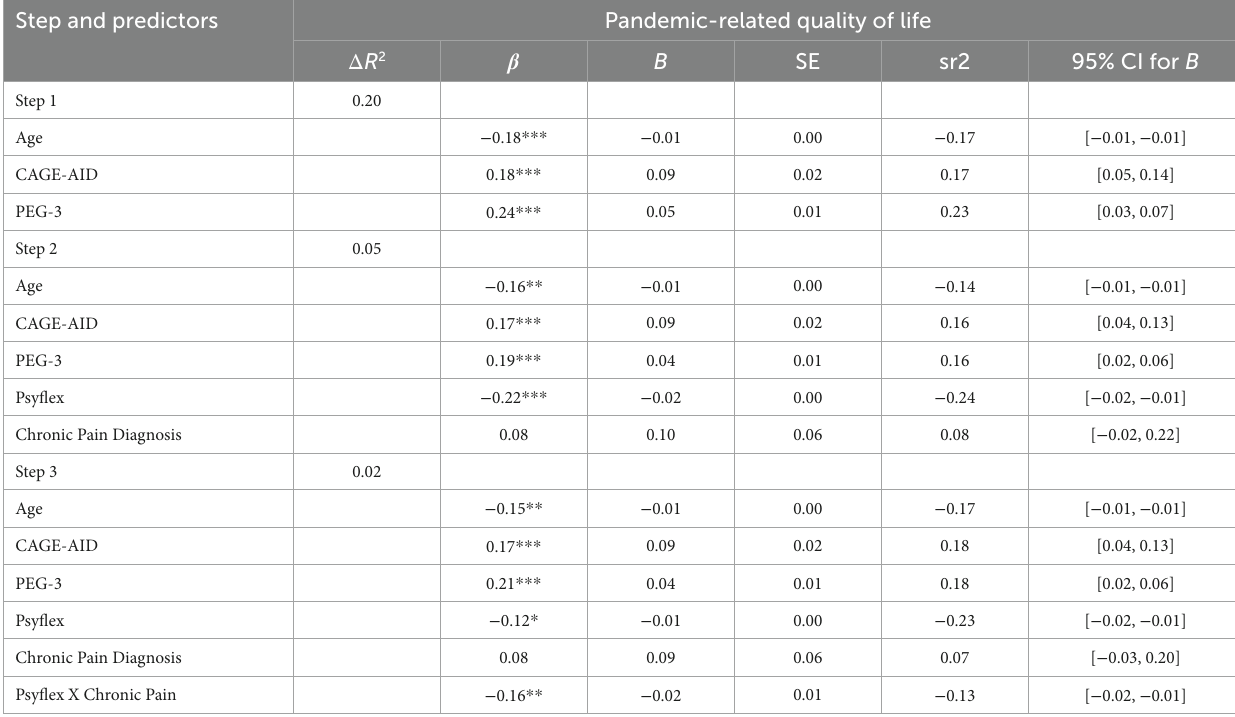
TABLE 4 Hierarchical multiple regression testing interaction model on pandemic-related quality of life.